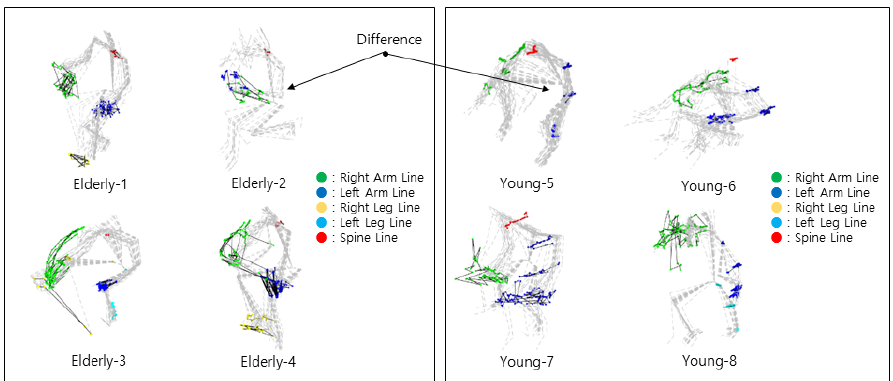
Figure 8. Difference matching analysis of skeleton-heatmaps between elderly people and young adults for the behavior of eating food with a fork.